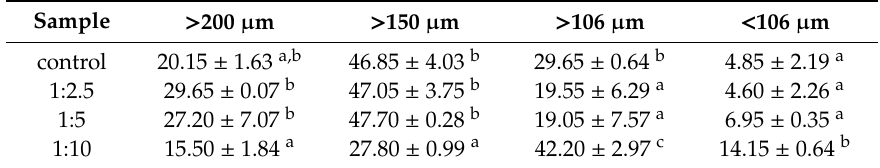
Table 1. Distribution of di ff erent fraction size in